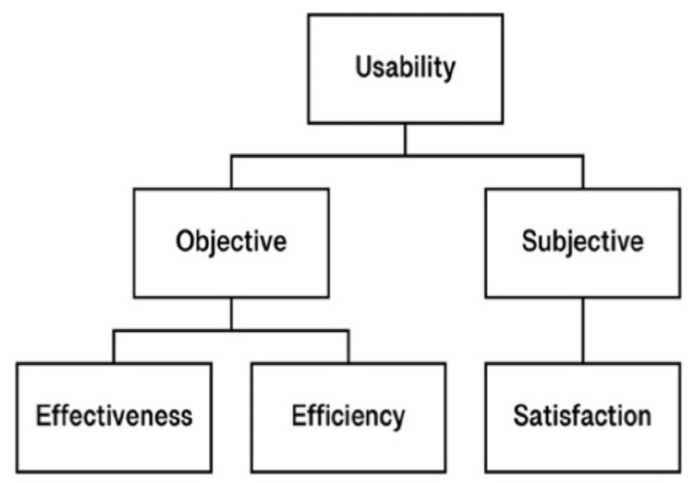
Figure 2. A Framework of Usability According to Yen’s Health IT Usability Evaluation Model